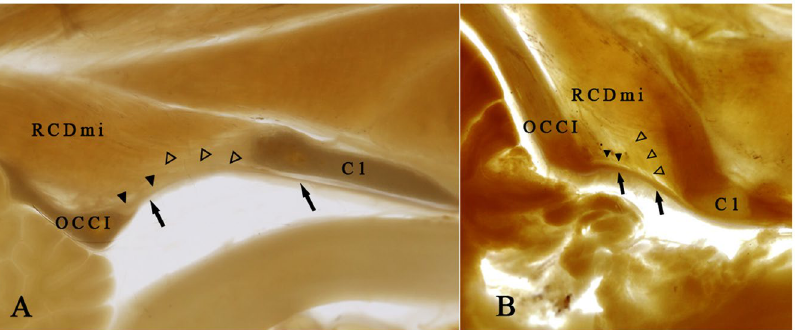
Figure 6. P45 plastinated sheets (median sagittal section) showing the fibrous fusing connections of the RCDmi, the PAO membrane and the spinal dura mater. ( A ) The median sagittal plane of Canisfamiliaris . ( B ) The median sagittal plane of Macacamulatta . ( A,B ) Showed that the fiber bundles ( Δ ) were found protruded from the RCDmi and pierced into the PAO membrane ( ▲ ), and finally connected with the spinal dura mater ( ↑ ). OCCI: occipital bone. C1: atlas. RCDmi: rectus captious dorsal